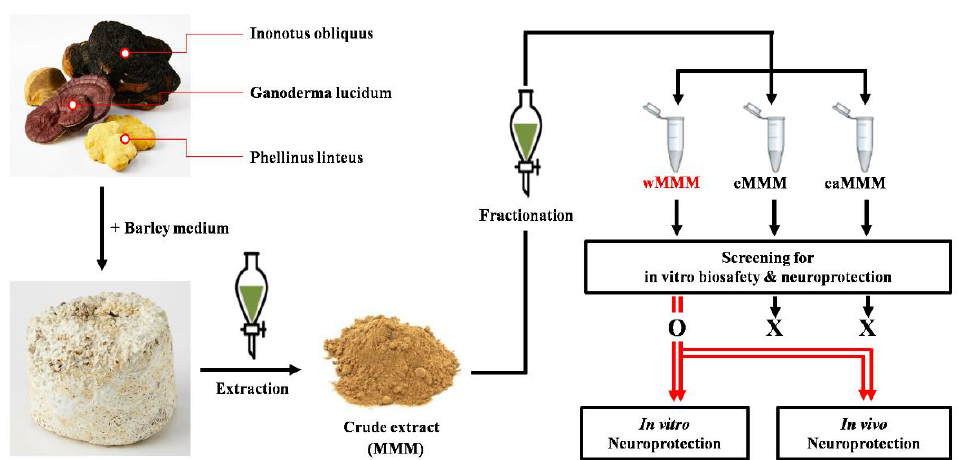
Figure 1. Time flow of this study. Barley flour, a growth medium, was inoculated with mycelia of Phellinus linteus , Ganoderma lucidum , and Inonotus obliquus yielding the mixed mushroom mycelia (MMM). The crude extract of MMM was further partitioned with the water-(wMMM), ethanolic- (eMMM), and ethyl acetate-extracts of MMM (eaMMM). Among the three extracts, the extract with the highest biosafety and neuroprotective efficacy were selected using an in vitro screening platform. After demonstrating wMMM as a feasible form, more detailed studies of in vitro neuroprotective effects and the possible in vivo neuroprotection of wMMM were carried out using PC-12 cells challenged with glutamate-induced excitotoxicity and a focal cerebral ischemia rat model, respectively.